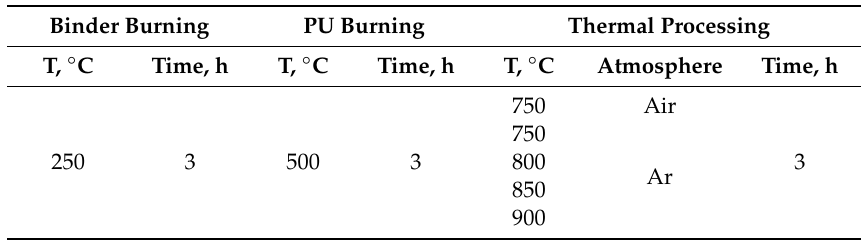
Table 1. Thermal processing conditions for binder and polyurethane (PU) burn out and thermal processing of the open-cell aluminum